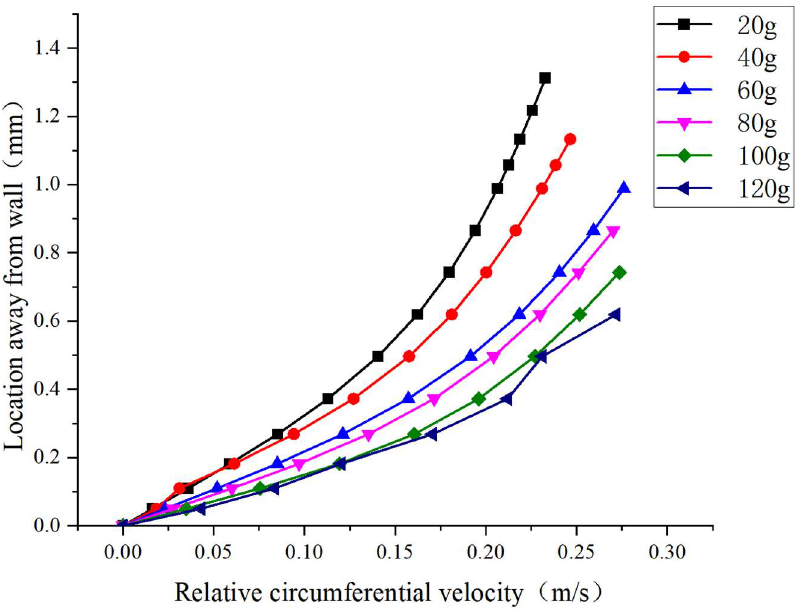
Figure 13. The relative circumferential velocity of different flow layers with different centrifugal acceleration.